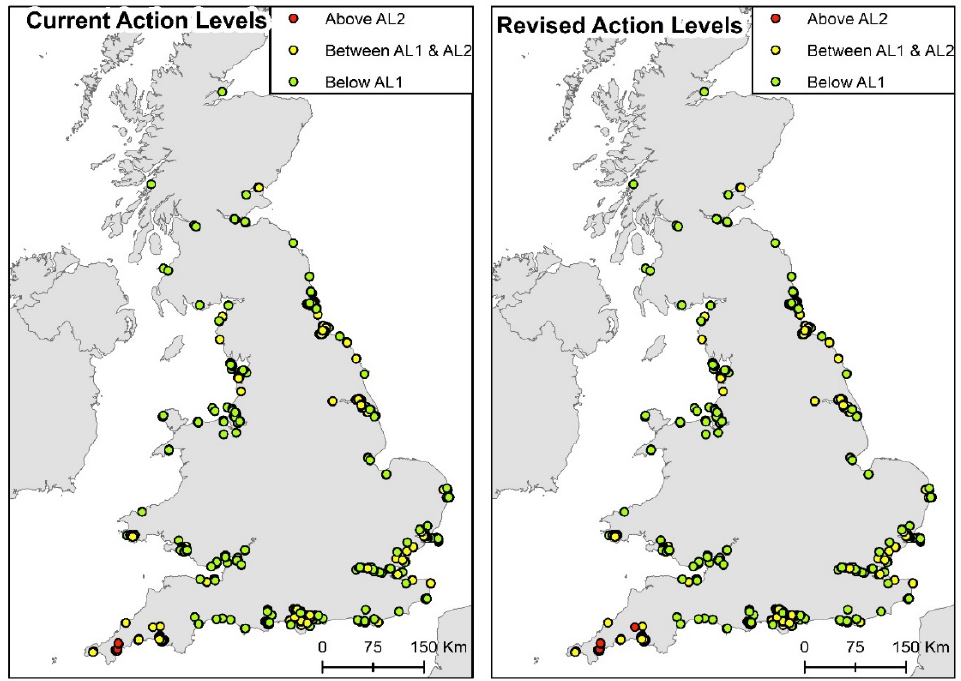
Figure 1. Maps showing the differences between the current ALs and revised ALs for arsenic (As). Samples above AL2 are indicated in red. Figure adapted from [13].